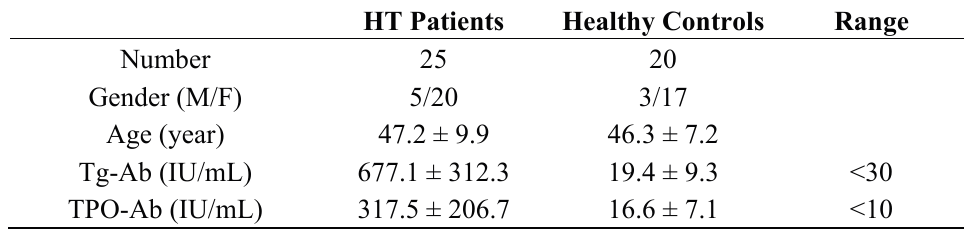
Data correspond to the arithmetic mean ±